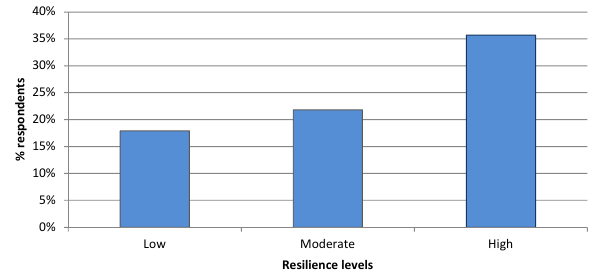
Fig. 4. Influence of visiting information websites on resilience lev- els in Finland and Italy ( n = 529;